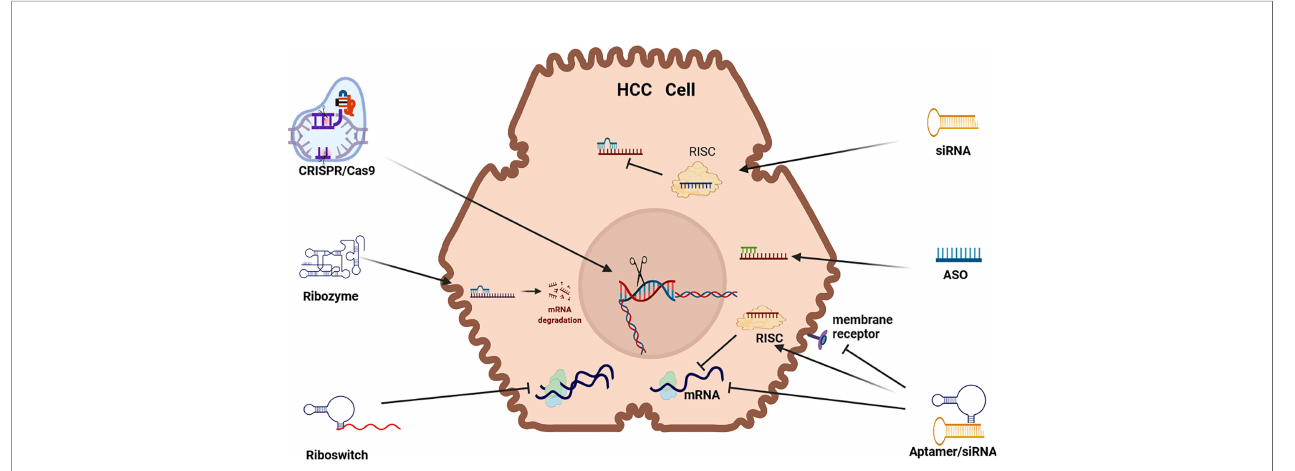
FIGURE 1 | RNAi Therapeutic options for HCC. siRNA (small interfering RNA), ASO (antisense oligonucleotides, Aptamer, Riboswitch, Ribozyme, CRISPR/Cas9 (clustered regularly interspaced short palindromic repeats/Caspase-9) mRNA (messenger RNA) (mRNA) RISC (RNA-induced silencing